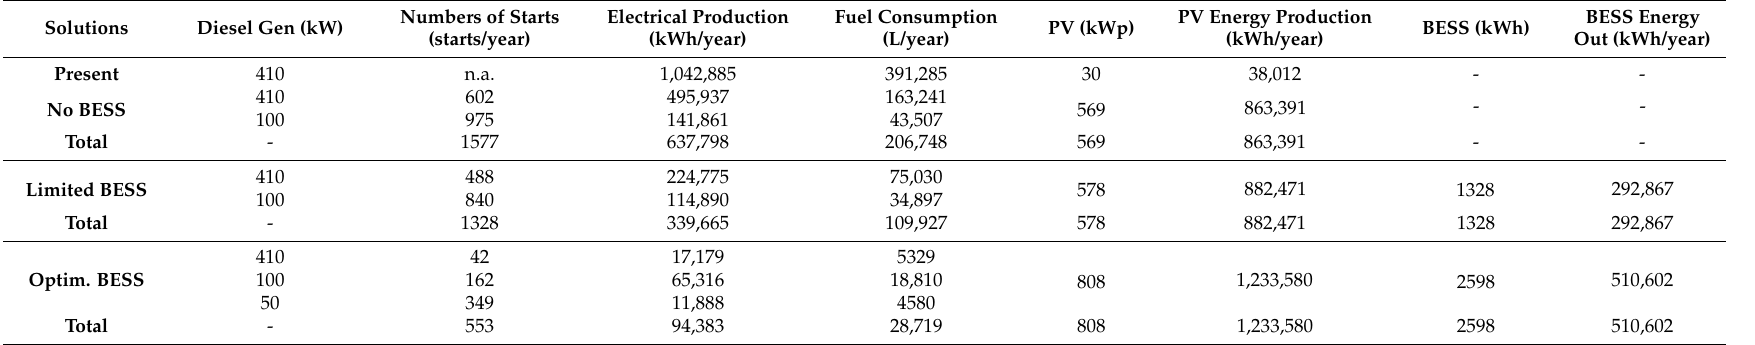
Table 2. Technical details of the proposed solutions.